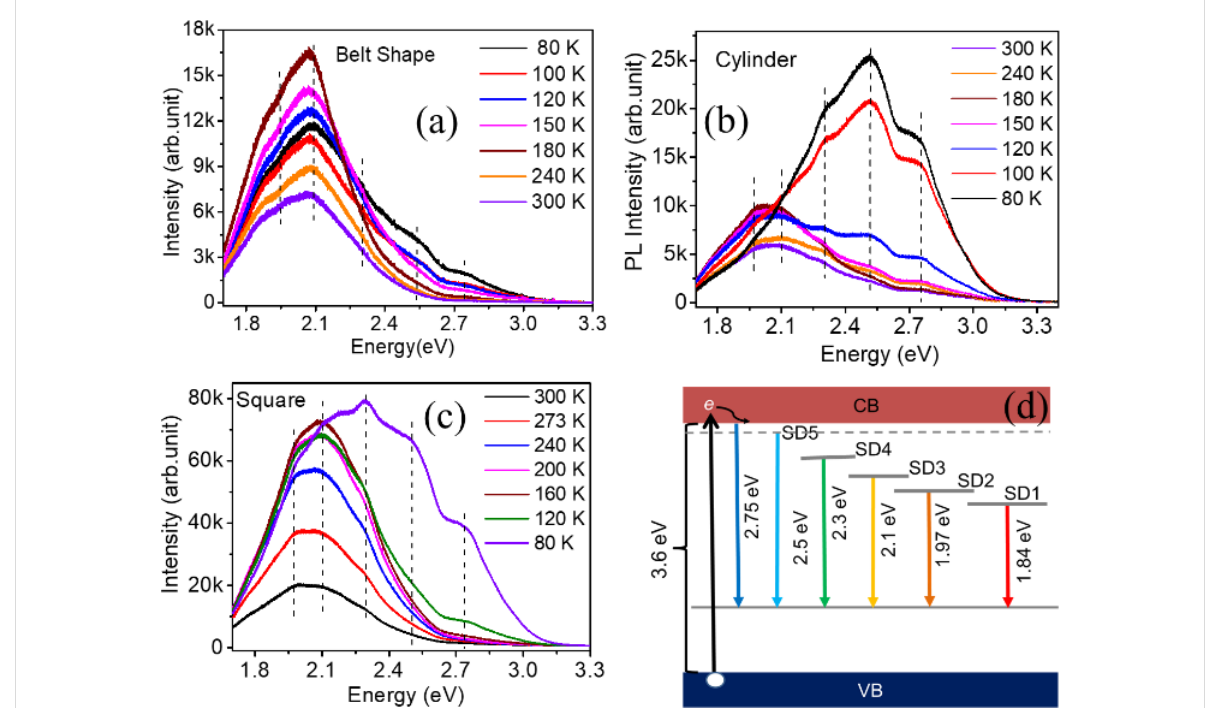
Figure 8: Temperature-dependent PL of the (a) belt-shaped NWs, (b) cylindrical-shaped NWs, (c) square-shaped NWs, and (d) the proposed band diagram for the SnO 2